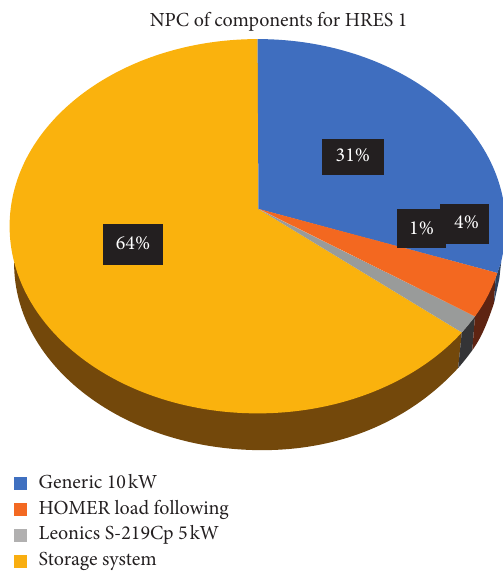
Figure 8: Details of NPC by component for HRES 1.